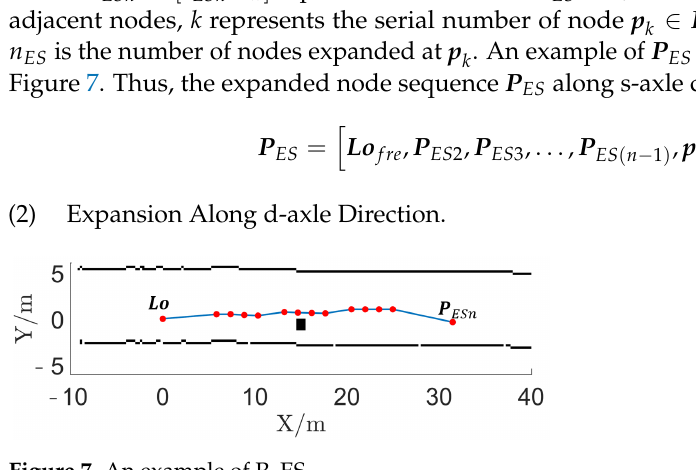
Figure 7. An example of P_ES.